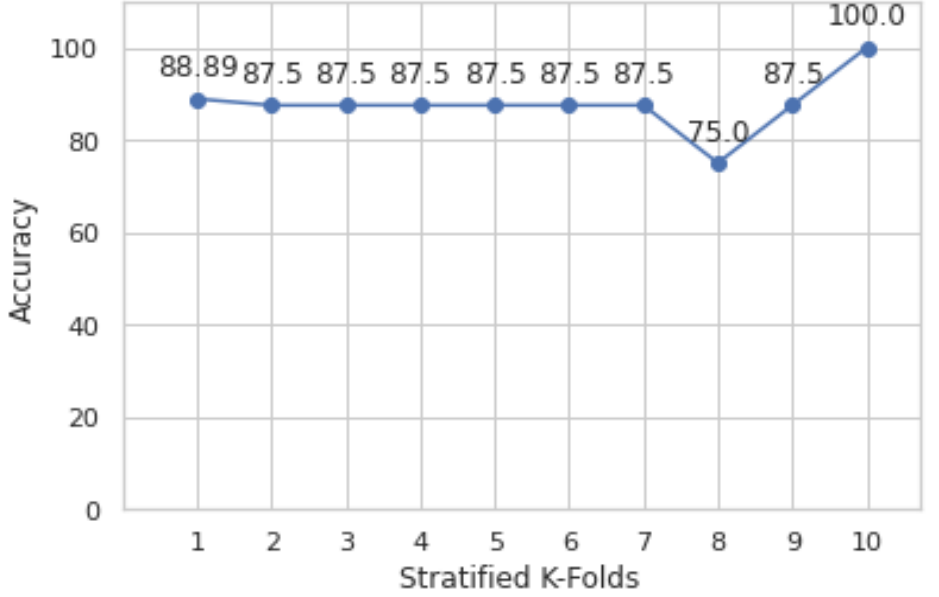
Figure 13. The classification accuracies of the DNN model using the stratified ten-fold cross-validation.